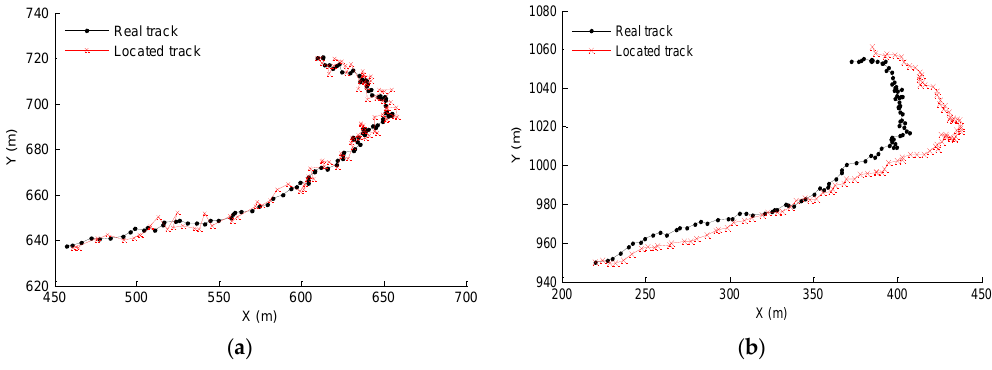
Figure 9. The comparison of ( a ) the beacon node’s track and ( b ) the unknown node’s track.